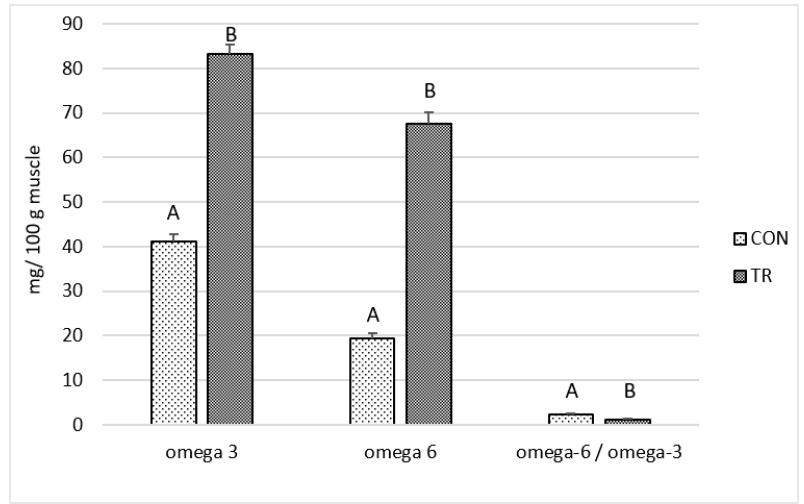
Figure 3. Omega-6 and omega-3 fatty acids (mg/100 g muscle) in Longissimus lumborum muscle of Charolais beef cattle fed a control diet (CON) and a diet supplemented with omega-3 lipid supplement (TR). n = 10; data are reported as mean ± SEM. A,B for p < 0.001.